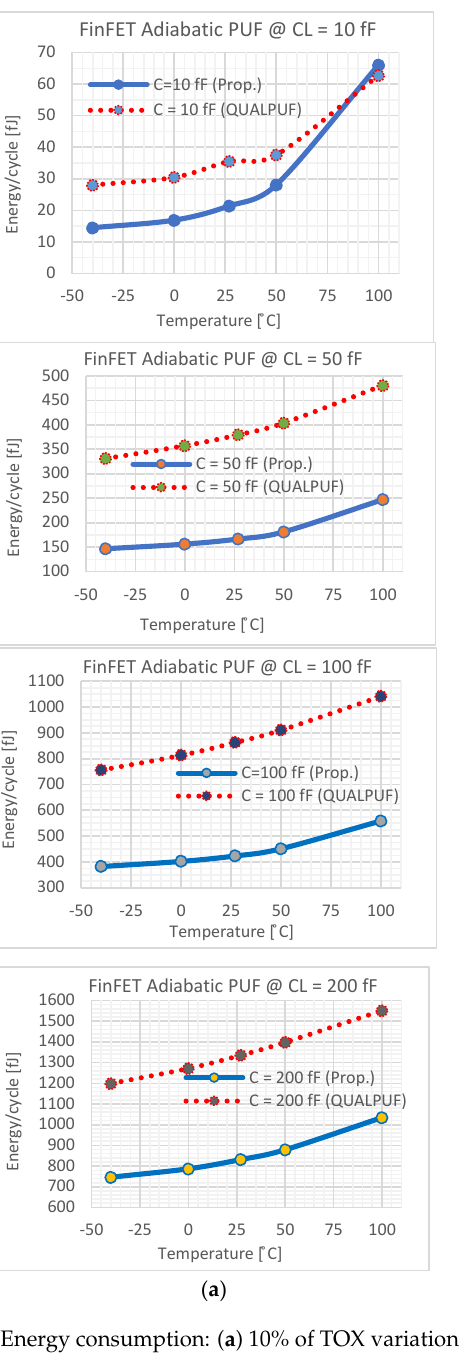
Figure 8. Uniqueness of the proposed FinFET-based TPCA-PUF (labeled as Prop.) versus QUAL- PUF under the V TH variation (4-bit PUF). Figure 9. Reliability of the proposed FinFET-based TPCA-PUF (labeled as Prop.) versus QUALPUF under the V TH variation (4-bit PUF).